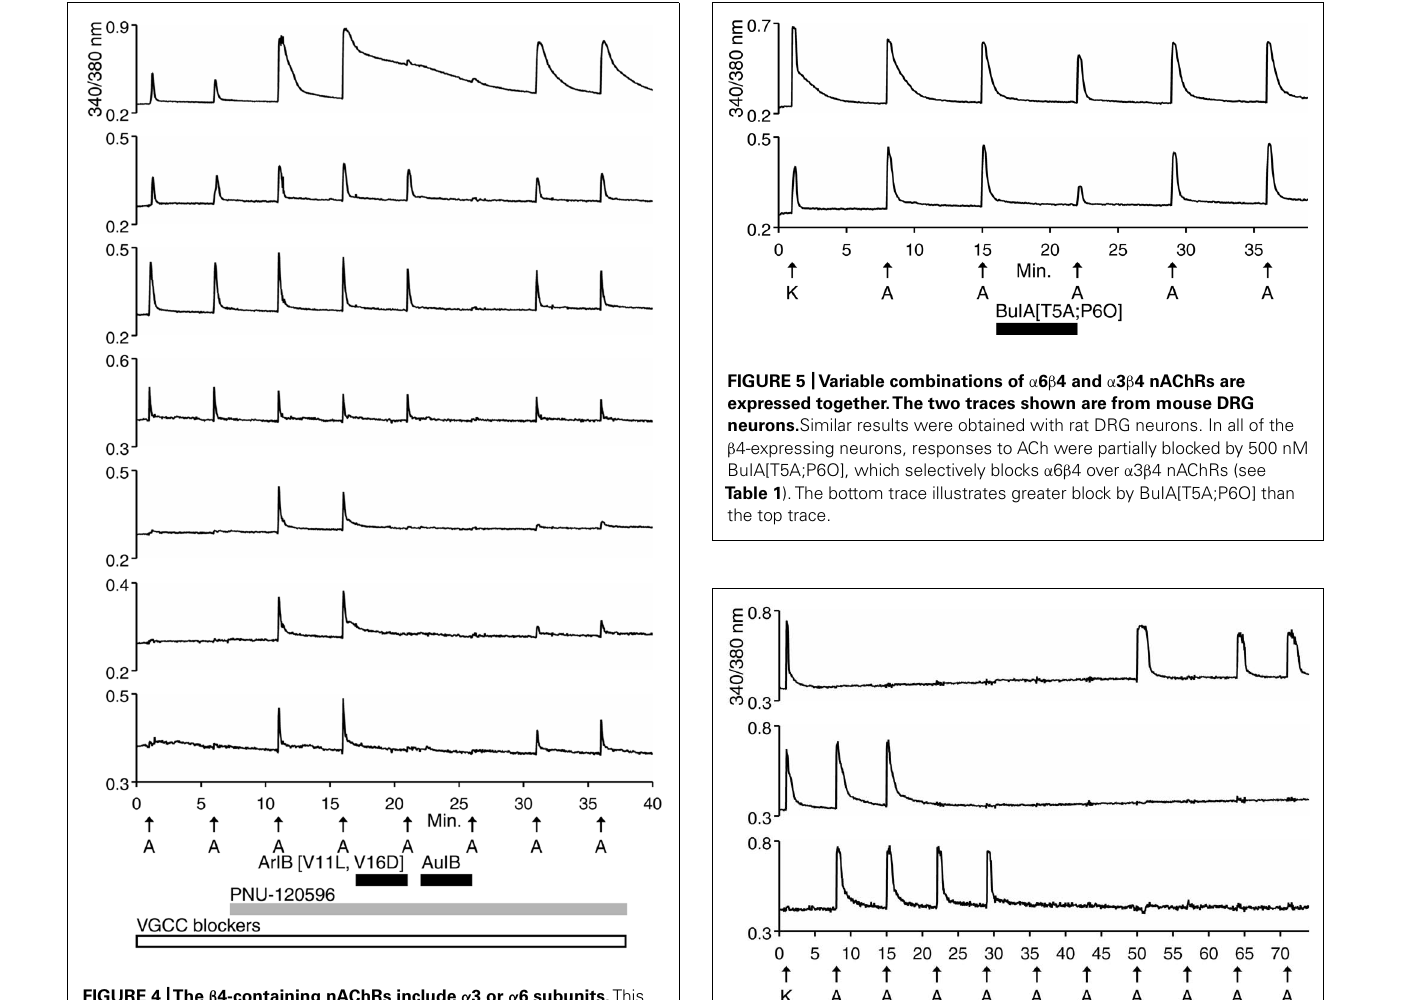
FIGURE 4 |The β 4-containing nAChRs include α 3 or α 6 subunits. This experiment was conducted with rat DRG neurons in the presence of a cocktail ofVGCC blockers, as described in the Figure 2 legend. PNU-120596 (1 μ M) was applied after the second ACh pulse, revealing the α 7-expressing subclass. ACh responses from the α 7-expressing subclass were blocked reversibly by 200 nM ArIB[V11L;V16D] (bottom three traces), which did not block the neuronal subclass that expresses primarily β 4-containing nAChRs. ACh responses from the β 4-expressing nAChRs were blocked reversibly by 50 μ M AuIB (second through fourth traces from the top), suggesting that the β 4-expressing nAChRs also contain α 3 or α 6 subunits (see Table 1 ). Short, black horizontal bars indicate when the different conotoxins were present in the bath.The top trace illustrates a